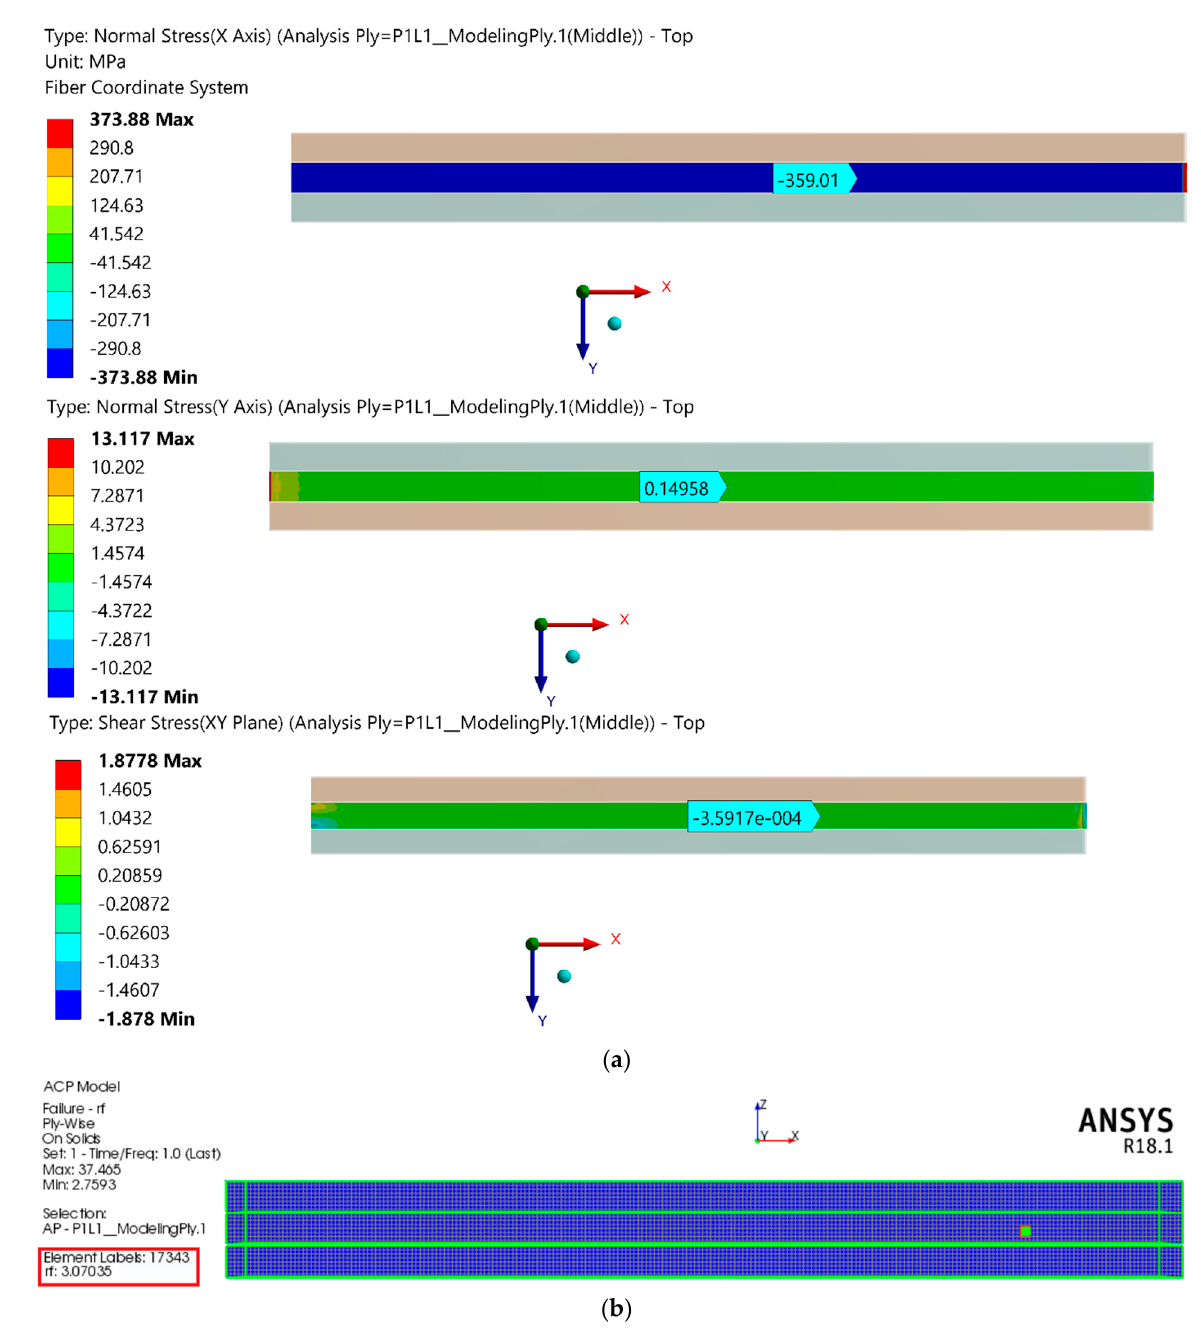
Figure A8. Stress components for a CFRP square beam with L8 layup: ( a ) normal stress components in the x ‐ and y ‐ directions and shear stress in the xy ‐ plane, and ( b ) safety ratio.